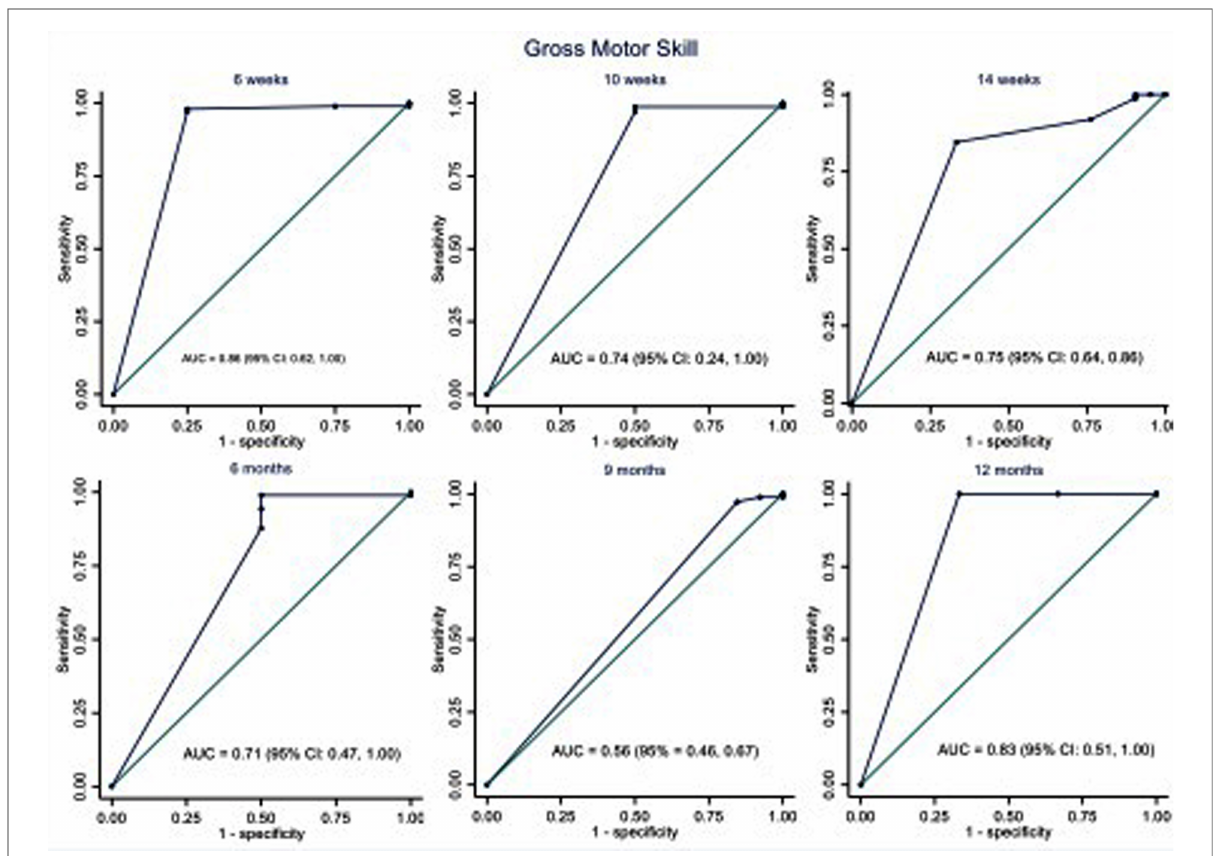
FIGURE 4 ROC curves showing the performance of ISDS in the detection of delay in gross motor domain at the age-speci fi c optimal